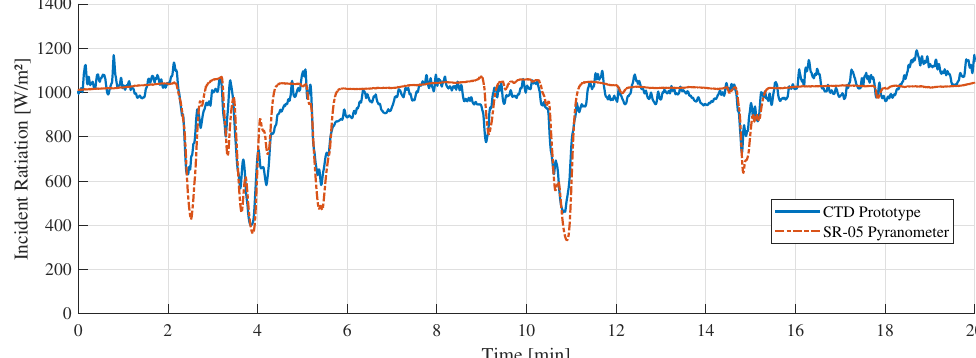
Figure 14. “B” measurement with partially cloudy conditions.